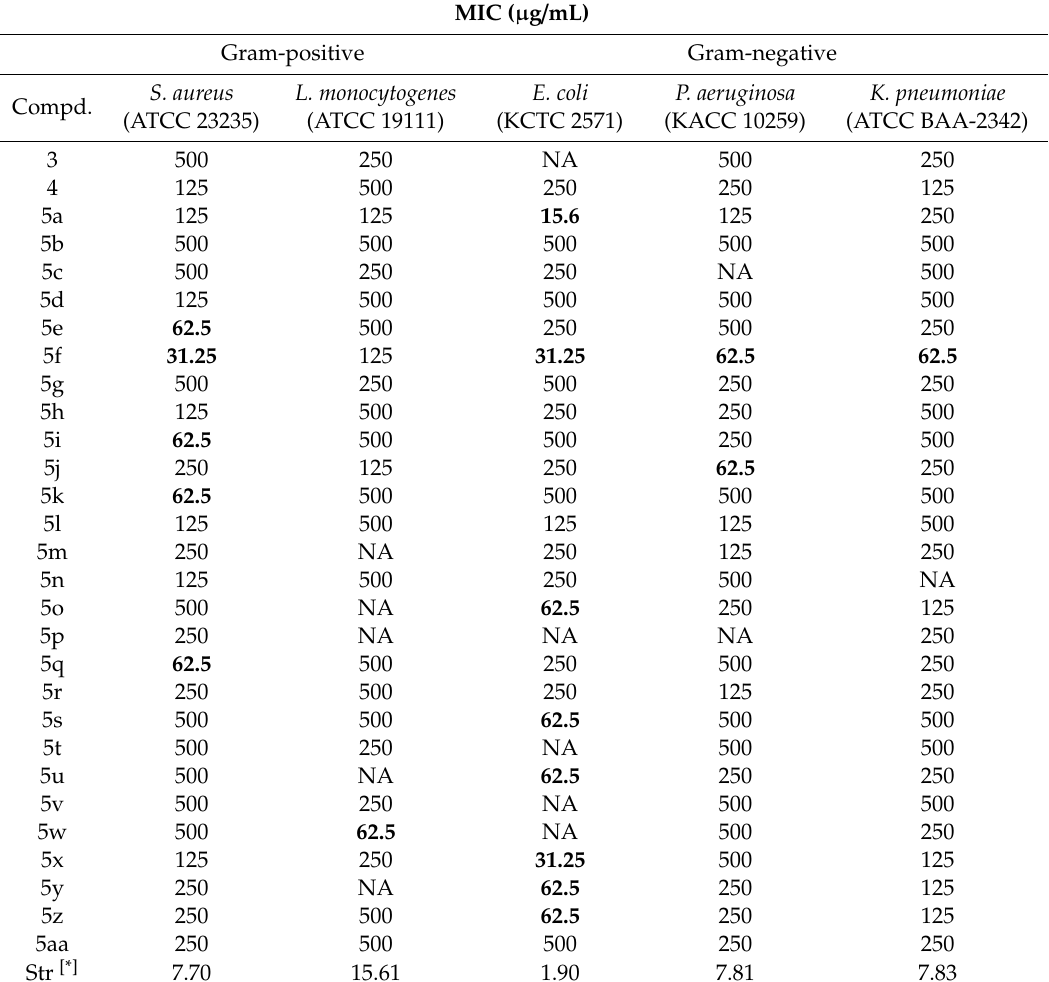
Table 1. In vitro antibacterial activity of 1,4-naphthoquinones ( 3 – 5aa ) expressed as MIC ( µ g / mL). MIC ( µ g / mL) Gram-positive Gram-negative